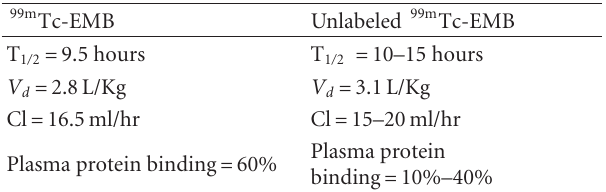
Table 3: Comparison of pharmacokinetic parameters of 99m Tc- EMB and unlabeled